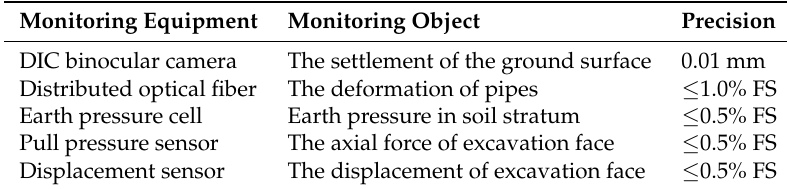
Table 2. Monitoring